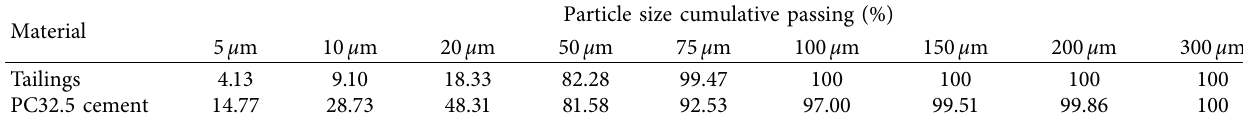
Table 3: Particle size distribution of tailings and PC32.5 cement.